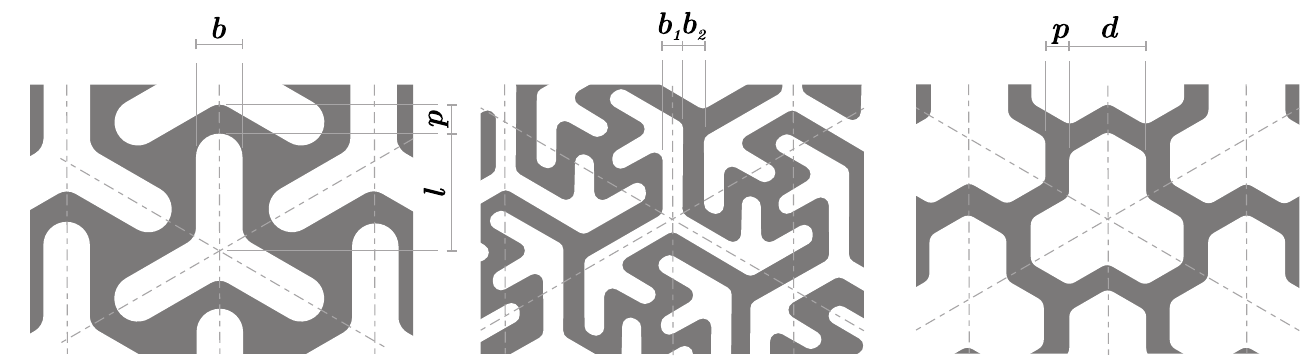
Figure 2. Selected pattern designs for flexible structures—three-pointed star pattern A ( left ), modified three-pointed star pattern B ( middle ) and tri-hexagonal pattern C ( right ).